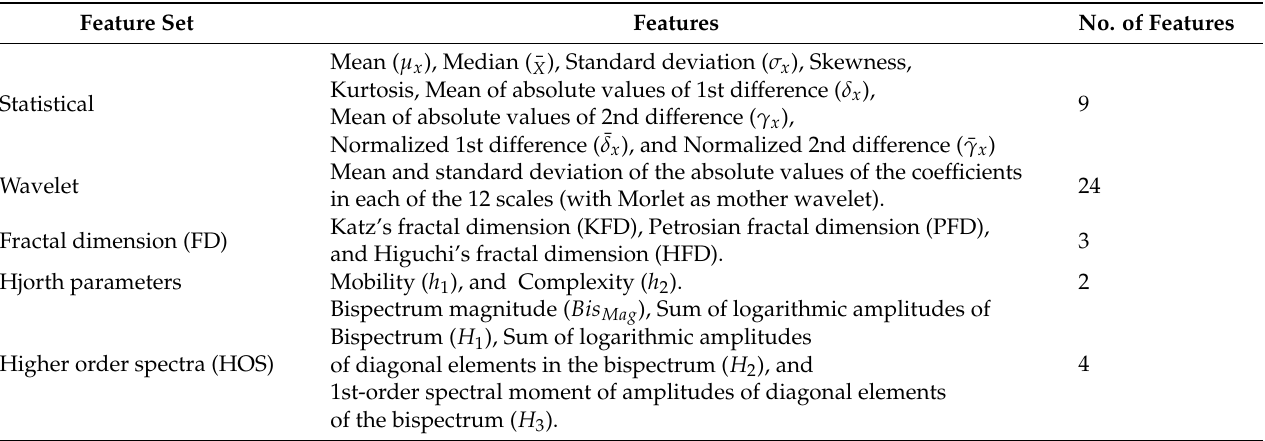
Table 2. Summary of EEG features employed in this